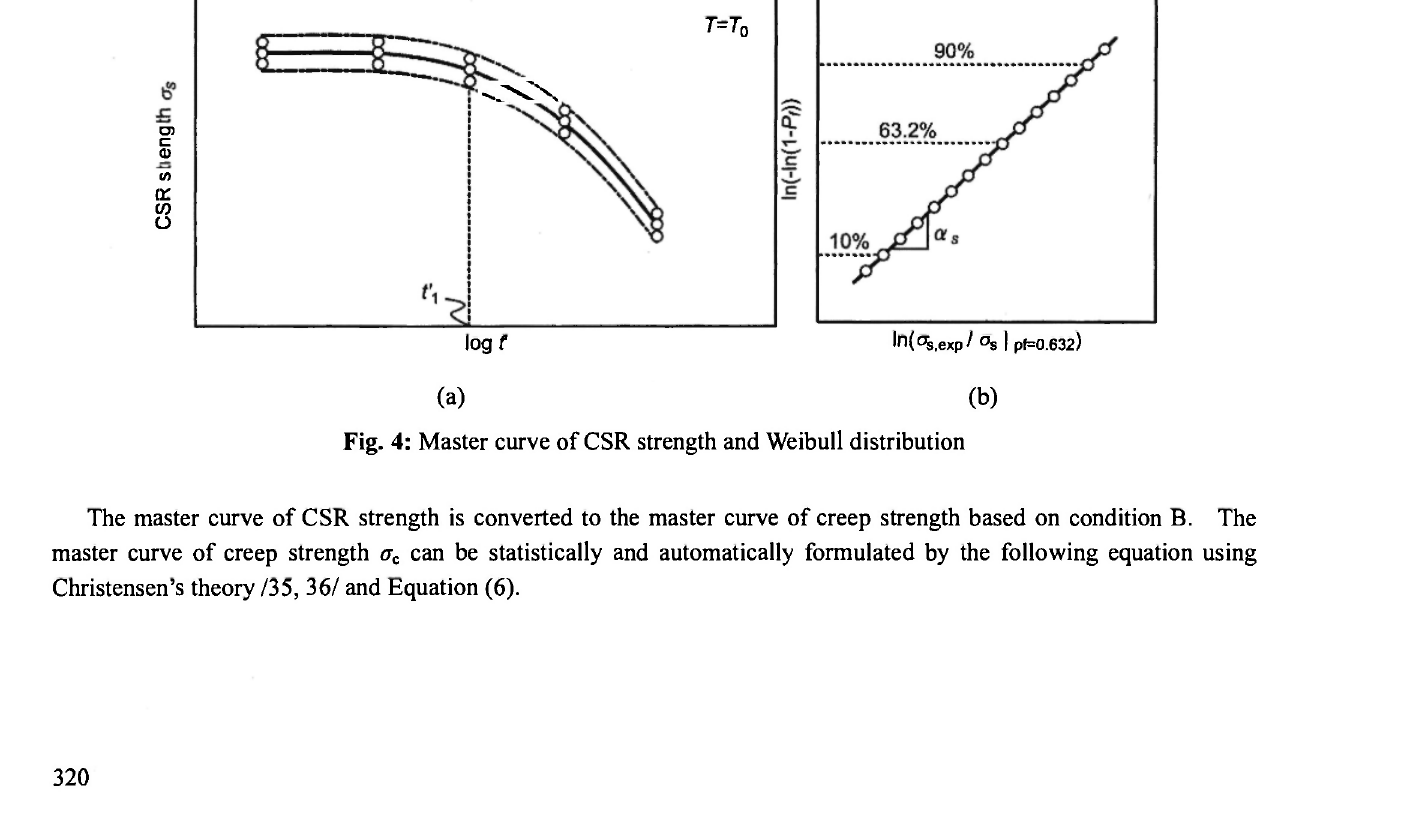
Fig. 3: CSR strength versus temperature measured at a constant stain rate